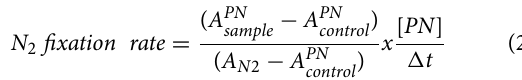
air-saturation to 83.0, 42.2, and 6.5%, respectively. By applying the set-up as shown in Figure 1 , dissolved gas was removed from water to 84.2 ± 0.9% O 2 air-saturation (mean ± s.d., n =